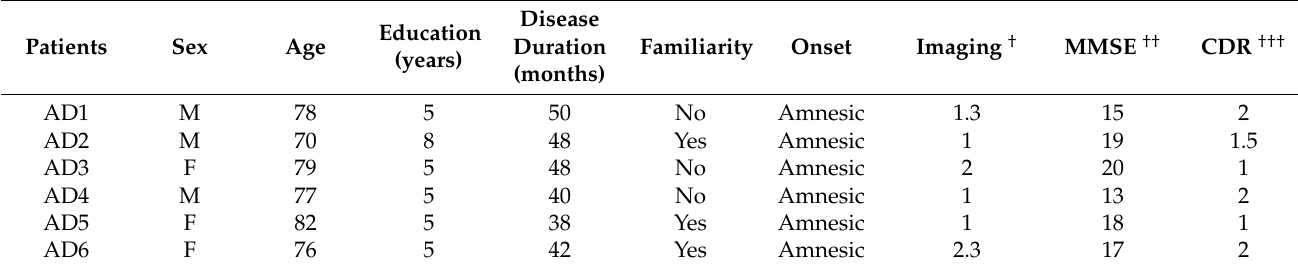
Table 5. Clinical characteristics of AD